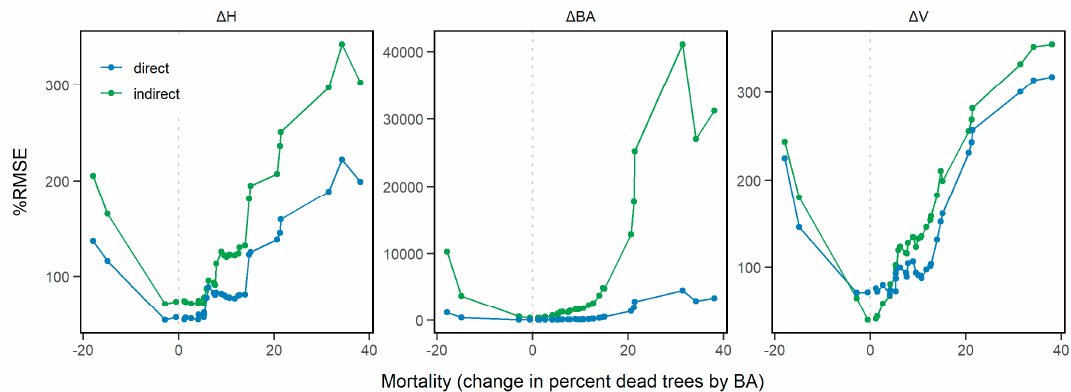
Figure 5. Relationship between model accuracy (root mean square error (RMSE)%) and plot-level mortality defined as change in percent dead tree by basal area.